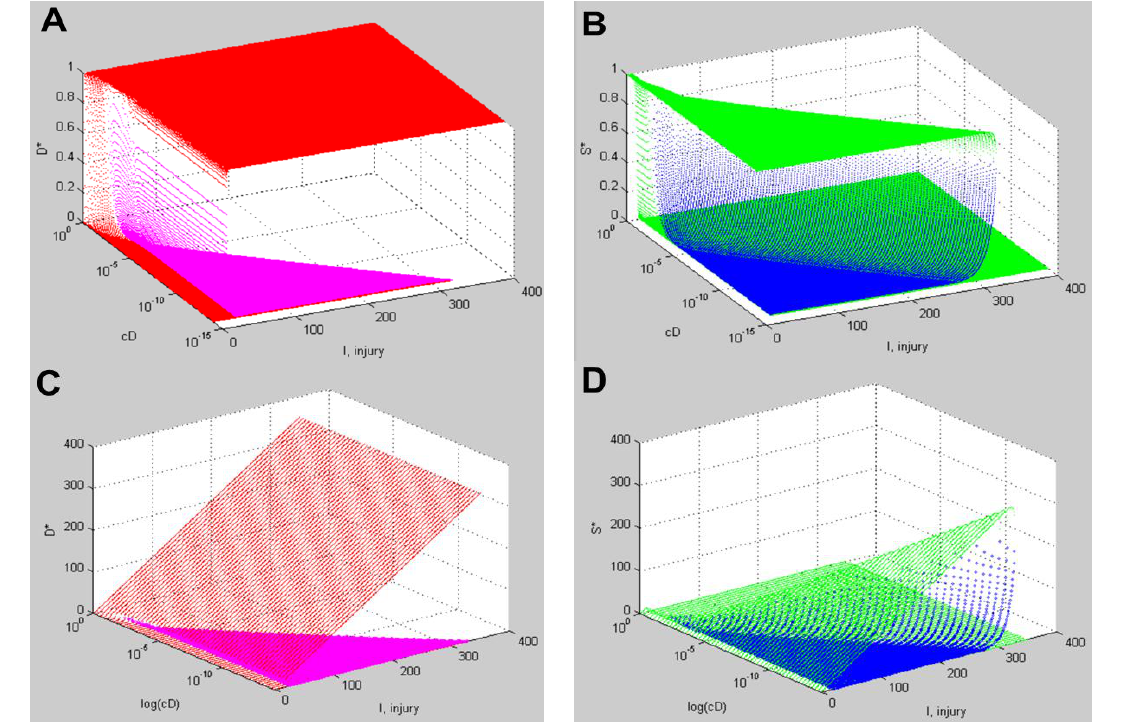
. D . In A – D , c is plotted as log( c ). Attractor D D D ) (orange line) and CBF vs. I (blue line). Axes as D x